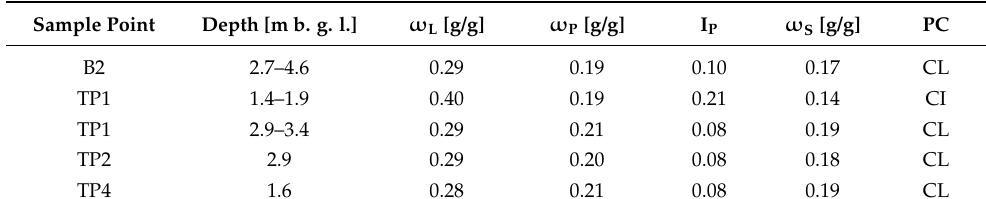
Table 6. Results of the determination of the liquid limit ( ω L ), plasticity limit ( ω P ), plasticity index (I P ) and shrinkage limit ( ω S ), as well as the soil class determined from the ISSCS plasticity chart (PC): CI = intermediate plastic clay, CL = low plastic clay.